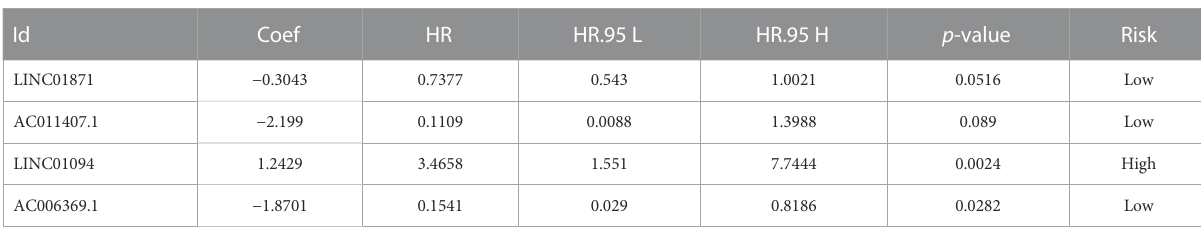
TABLE 2 Multivariate Cox results for